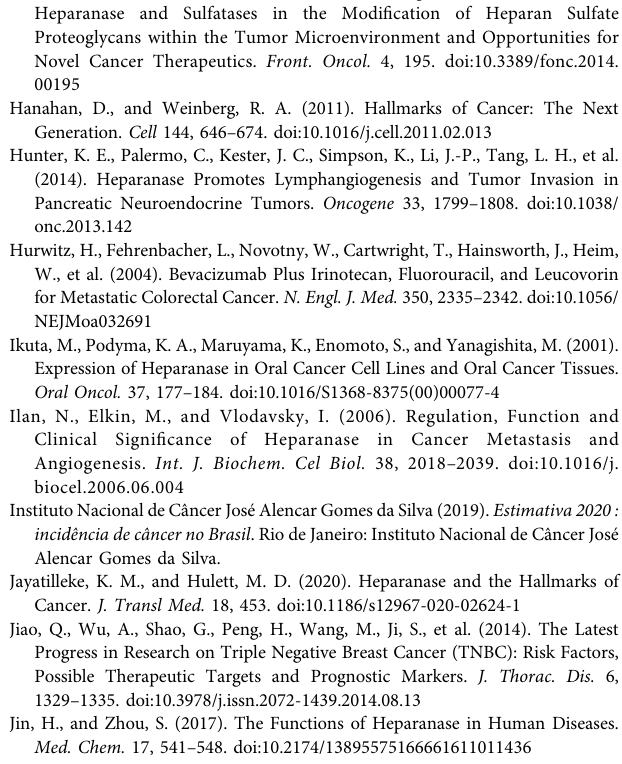
Supplementary Figure S1 | Analysis of Immuno fl uorescence (IF) and Western Blot (WB) from OSCC cellular compartments. (A) In the SCC-9 cell line, nuclear and cytoplasmic HPSE1 protein expression was determined by IF and showed higher HPSE1 expression in the cytoplasmic compartment compared to the non-malignant HGK cells, in which HPSE1 expression was more restricted to the nuclear fraction. (B) Western blotting showing the distribution of HPSE1 protein expression pattern and its quanti fi cation (C) in SCC9 cells, and the respective suppressed (ShRNA) and upregulated (OrfRNA) derived clones within the subcellular compartments. The results showed a signi fi cant reduction in cytoplasmic protein levels of OSCC by HPSE1-shRNA silencing, while its induced upregulation signi fi cantly increased cytoplasmic HPSE1 expression in SCC-9 cells. N, Nucleus; C, Citoplasm. SupplementaryFigureS2| Multivariateanalysesshowedasigni fi cantassociationof combinations of HPSE1 levels and pTNM (A) , pT (B) , and pN (C) stages for Disease Free-Survival. Survival curves indicated largely improved discriminatory